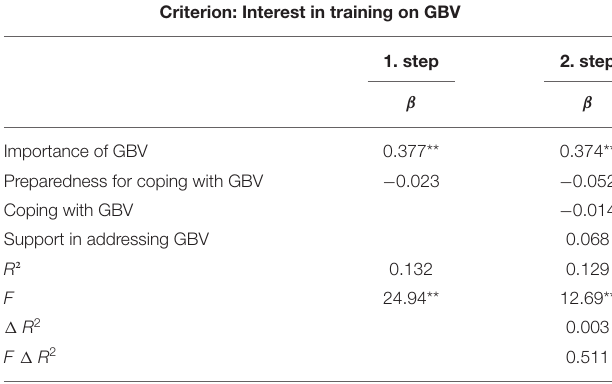
TABLE 3 | Prediction of interest for training on GBV for teachers and other school